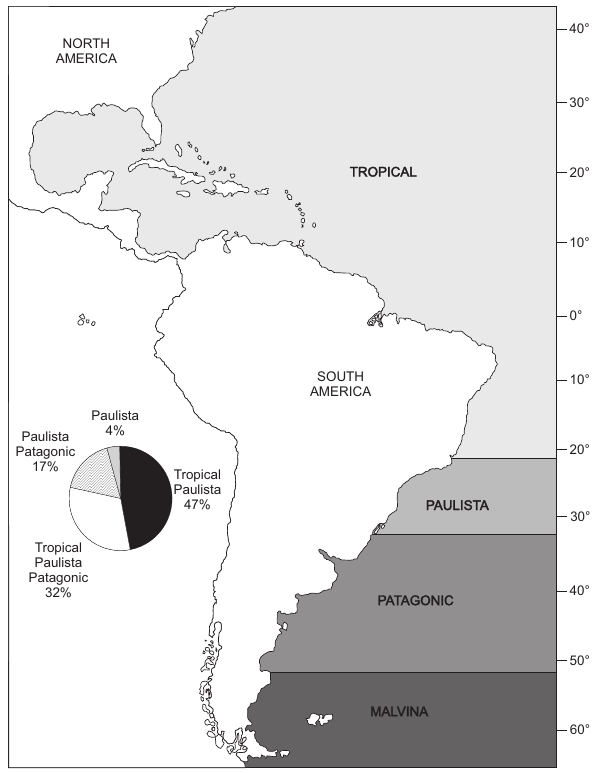
Figure 2. Zoogeographical provinces of the western South Atlan- tic according to P ALACIO (1982) and distribution of bivalve and gastropod species recorded for Sambaqui da Tarioba, Rio de